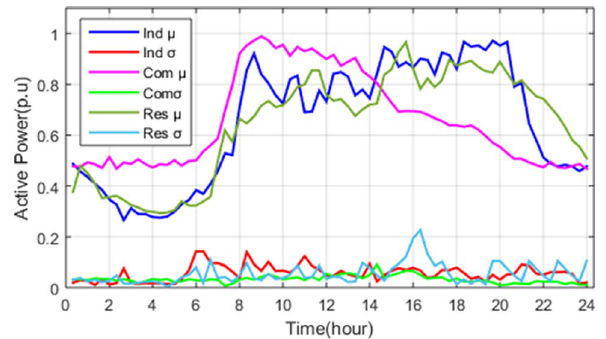
Figure 16. Analysis of daily pro fi les of THD difference when random value of medium voltage grid and PEV harmonic compared to base case.